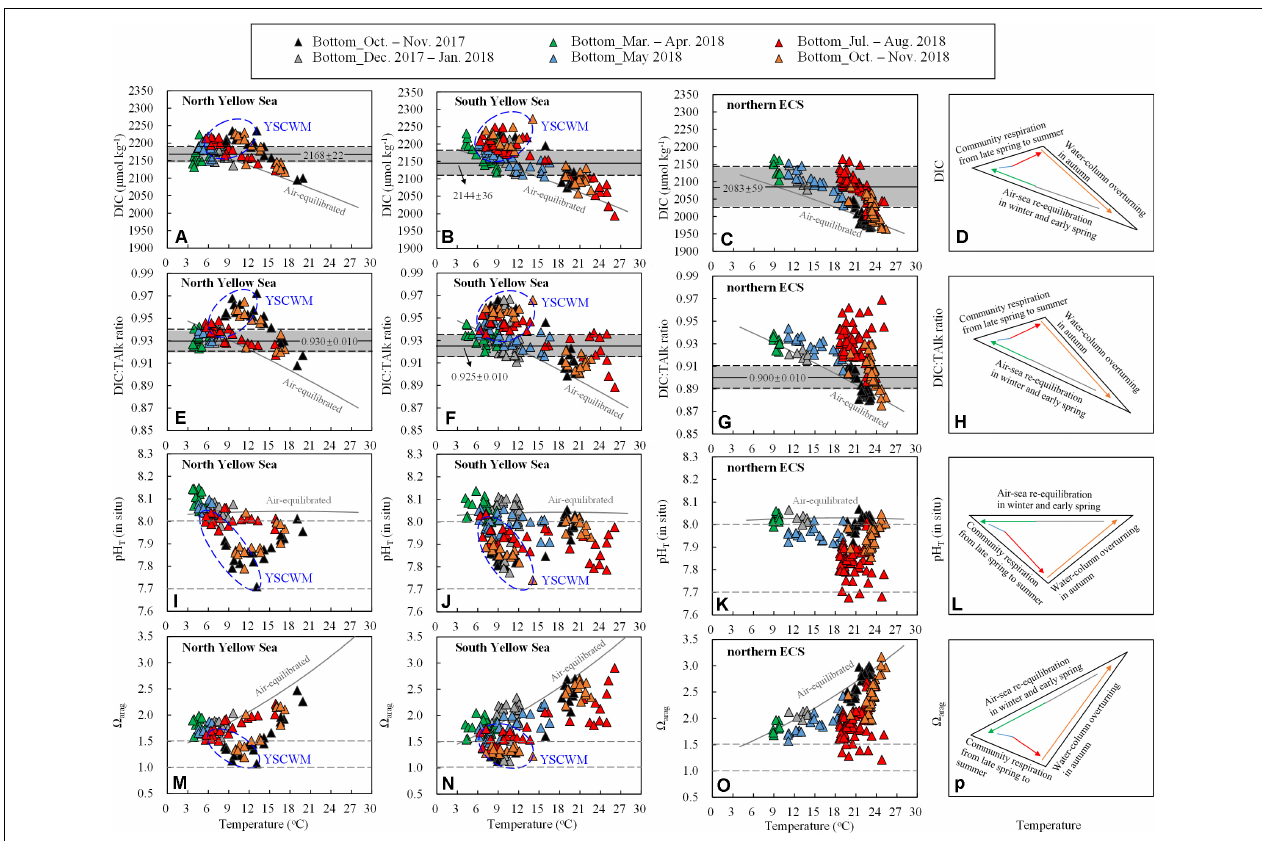
FIGURE 6 | Bottom-water (A–C) DIC, (E–G) DIC:TAlk ratio, (I–K) pH T ( in situ ), and (M–O) (cid:127) arag versus temperature. Solid gray curves are air-equilibrated levels of bottom-water DIC, DIC:TAlk ratio, pH T and (cid:127) arag (corresponding to a mean air-equilibrated f CO 2 value of 415 ± 5 µ atm during our seasonal cruises in 2017–2018) at mean salinity and TAlk in the North Yellow Sea (salinity = 32.1, TAlk = 2316 µ mol kg - 1 ), South Yellow Sea (salinity = 32.2, TAlk = 2305 µ mol kg - 1 ) and northern ECS (salinity = 33.0, TAlk = 2243 µ mol kg - 1 ). Data for the YSCWM are enclosed within a blue ellipse. In (A–C) and (E–G) , gray shaded areas represent mean ± SD of wintertime/springtime DIC and DIC:TAlk ratios in the North Yellow Sea, in the South Yellow Sea, and in the northern ECS. Major processes controlling seasonal variations of bottom-water (D) DIC, (H) DIC:TAlk ratio, (L) pH T ( in situ ) and (P) (cid:127) arag are also